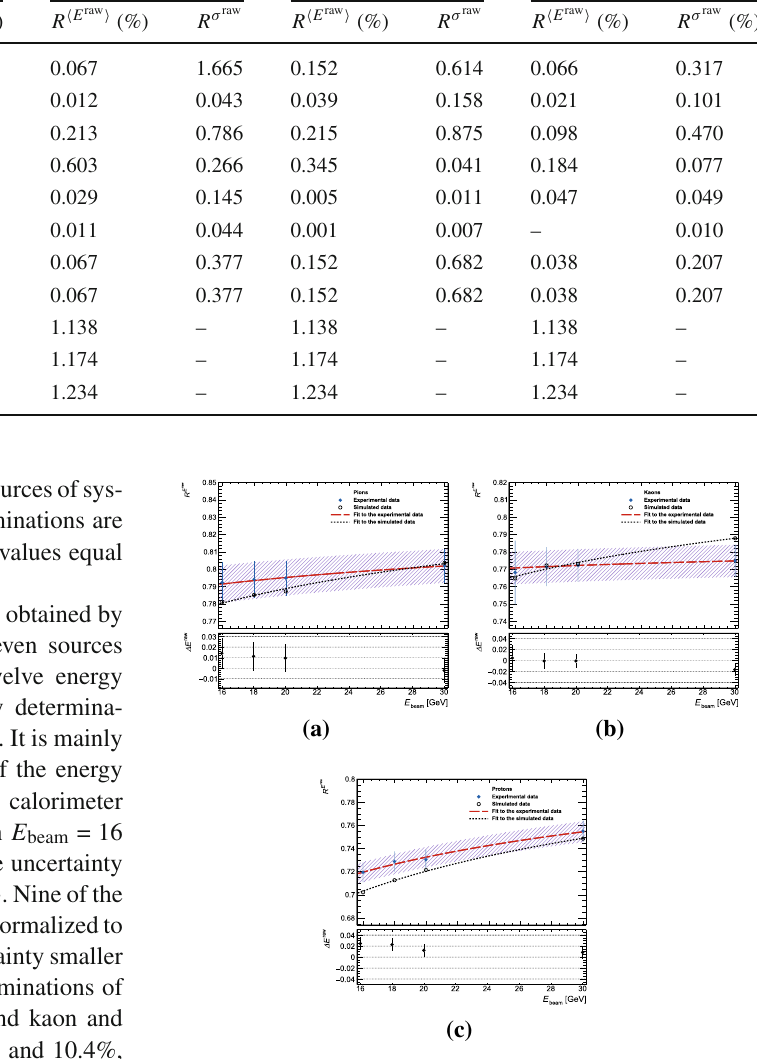
Fig. 20 Energy response normalized to incident beam energy, R (cid:6) E raw (cid:7) , measured (blue circles) and predicted by MC simulation (black circles) as a function of beam energy obtained in the case of pion ( a ), kaon ( b ) and proton ( c ) beams. The experimental uncertainties include statistical and systematic effects combined in quadrature. Only statistical uncer- tainties affect simulated results. The red dashed (black dotted) curves are fits of the Eq. (22) to the experimental (simulated) data points. In case of experimental determinations the dashed blue hashed bands were obtained by using the correlated systematic uncertainties. In the bottom of the histograms are shown the fractional differences Δ E (cid:6) raw (cid:7) defined in Eq. (12). The uncertainties include statistical and systematic effects combined in